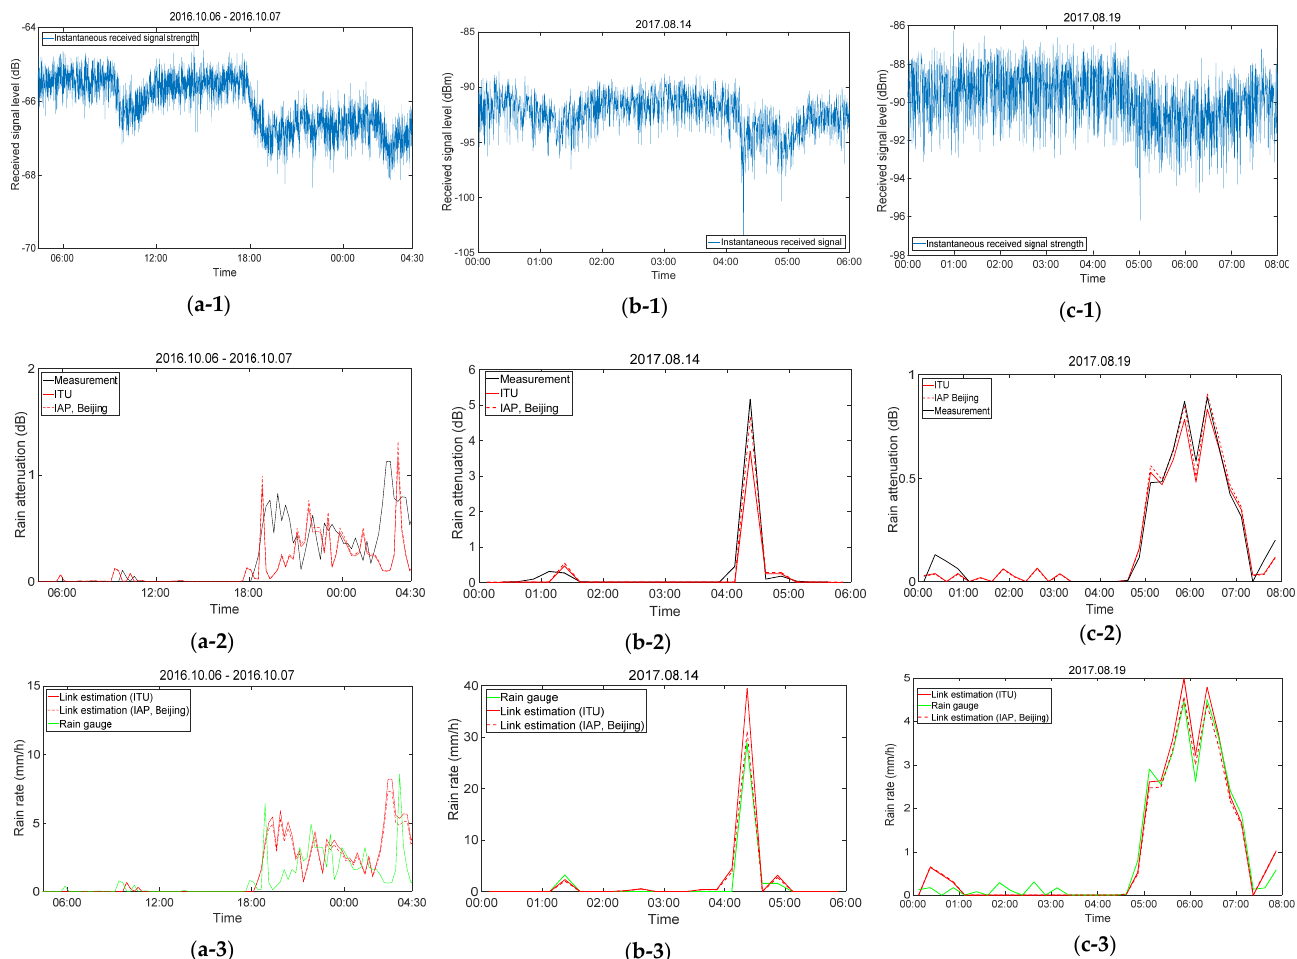
10 of 15 Figure 5. The comparison between power law coefficients ( a, b ) from the ITU-R P. 838-3 and the values derived from the measurement for ( a ) a 25 GHz link in stratiform precipitation ( b ) a 25 GHz link in convective precipitation ( c ) a 38 GHz link in stratiform precipitation ( d ) a 38 GHz link in convective precipitation. 3.3. Estimated Rainfall Rate Using Millimeter-Wave Link Most of the existing rainfall rate retrieval studies are based on the power law model and coefficients given by the ITU-R document. Since climatic variations in different re- gions affect the rainfall characteristics, local information on raindrop size distributions has proven to be useful for formulating a more precise statistical prediction model for the local A-R relationship [47]. Therefore, it is necessary to conduct raindrop size distri- bution and millimeter-wave experiments to provide insightful information for research on the rainfall rate inversion of millimeter-wave links. The performance of the improved A-R model is evaluated using propagated signal power based on measurement data in selected rainfall events as presented in Figure 6.